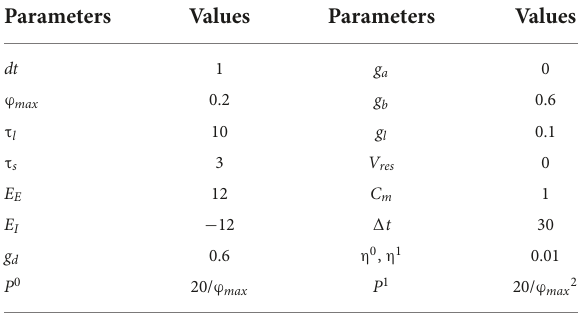
Values Parameters